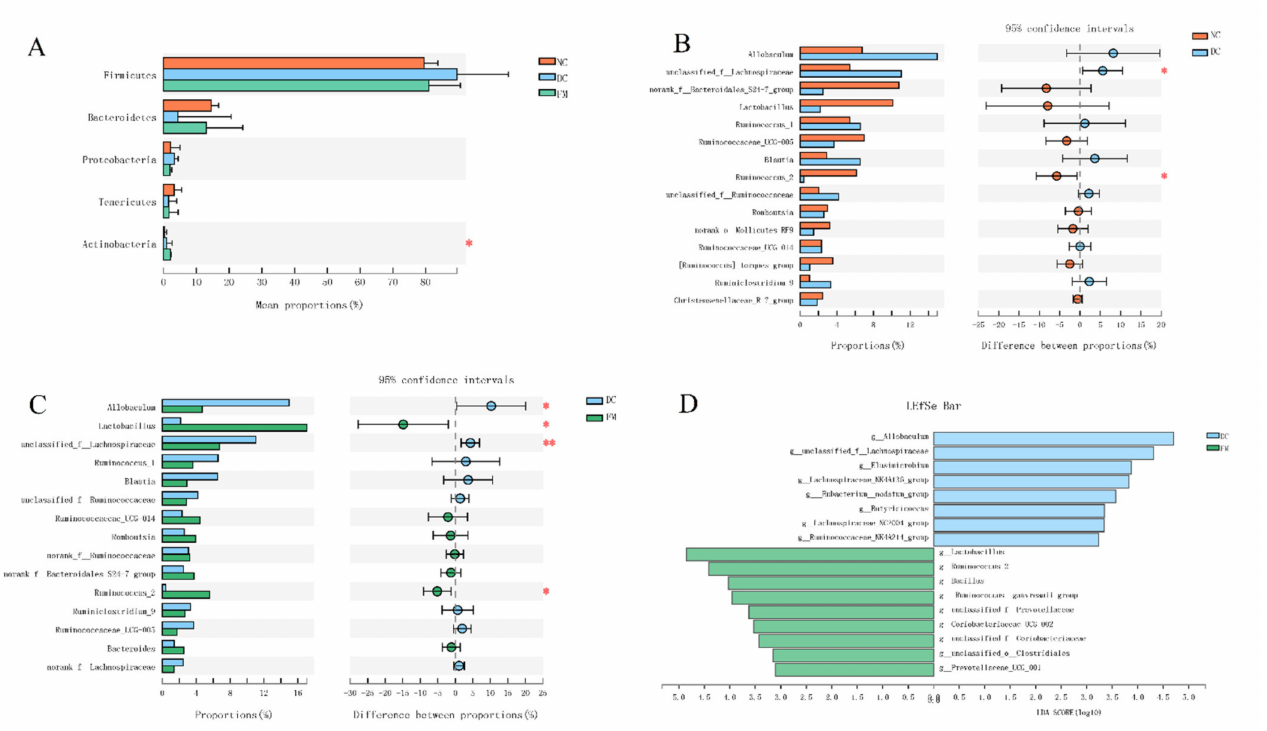
Figure 3. Effect of foxtail millet supplementation on the composition of gut microbiota: ( A ) phylum-level taxonomic distributions; ( B , C ) mean proportions of 15 key genera in different groups; ( D ) LDA scores derived from LefSe analysis, LDA > 3.0. Data were represented as mean ± SD. NC, normal control group ( n = 5); DC, diabetic control group ( n = 5); FM, foxtail millet supplementation group ( n = 7). Differences between three groups were compared using one-way ANOVA with Tukey–Kramer post hoc test; differences between two groups were compared using Student’s T -test, * p < 0.05, ** p <